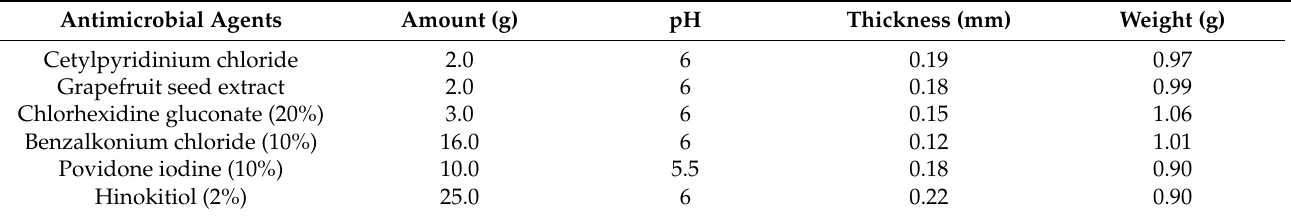
Table 1. Antimicrobial agents for processing of non-woven fabric